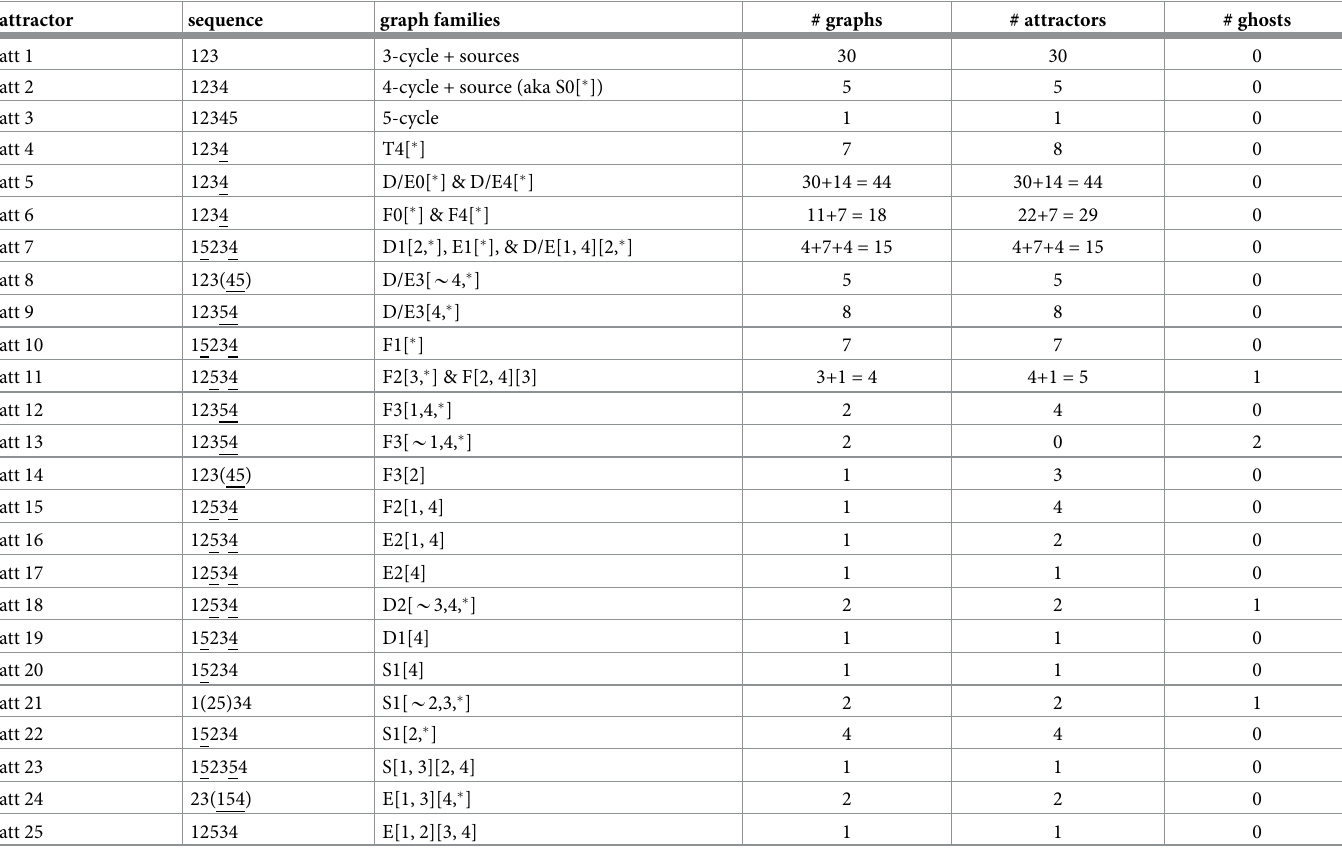
Table 3. Graph families for attractor classes of n = 5 oriented graphs with no sinks. The “ * ” notation indicates a forbidden edge, while � s indicate optional edges. For example, D2[ * 3,4, � ] represents the pair of graphs D2[1, 4] and D2[4], which have no edge to node 3. See Supporting information for more